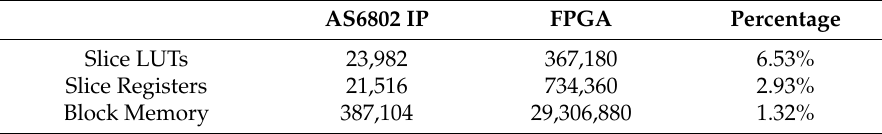
Figure 11. Synchronization precision of the four-node network. Table 3. Resource usage comparation based on Altera